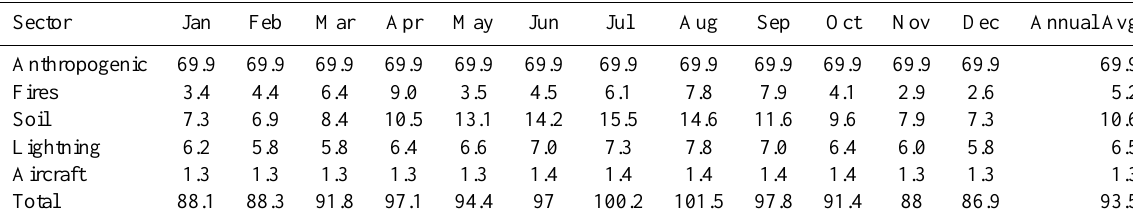
Table 4. NO emissions used in this study (global totals in Tgyr − 1